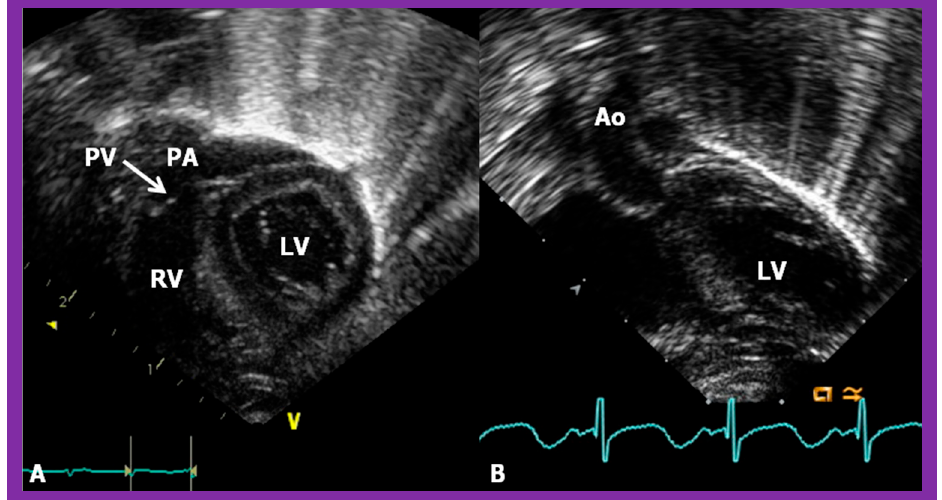
Figure 46. Echo images in subcostal long-axis projections of the right (RV) ( A ) and left (LV) ( B ) ventricles illustrating the position of the pulmonary valve (PV). The PV is located higher and anterior to the aortic valve (AV). The AV is located on the right side of the PV in straight posteroanterior view (not shown in this illustration). As expected, the LV is seen posteriorly while the RV is anterior. Aorta (Ao) and pulmonary artery (PA) are labeled. Replicated from reference [41].